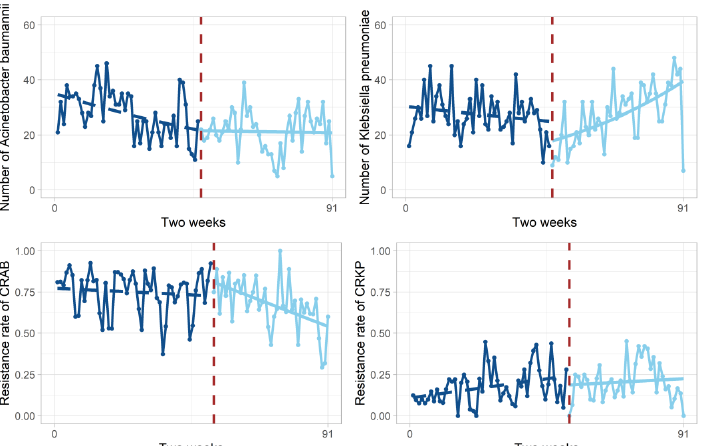
Figure 2. The change in outcome indicators every two weeks before and after COVID-19 outbreak. The dark blue dots represent the number (or resistance rate) before COVID-19 outbreak. The blue dots represent the number (or resistance rate) after COVID-19 outbreak. The dark blue dashed line represents the regression line before COVID-19 outbreak. The blue line represents the regression line after COVID-19 outbreak. Dark red dashed lines indicate breakpoints in the time series. The baseline level of K. pneumoniae detections was 30.34 strains/2 weeks ( p < 0.001). After the COVID-19 outbreak, the number of K. pneumoniae detections decreased by 4.13